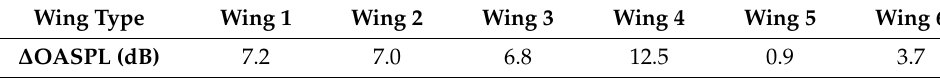
Table 4. Overall sound-pressure-level reduction for different bionic wings.